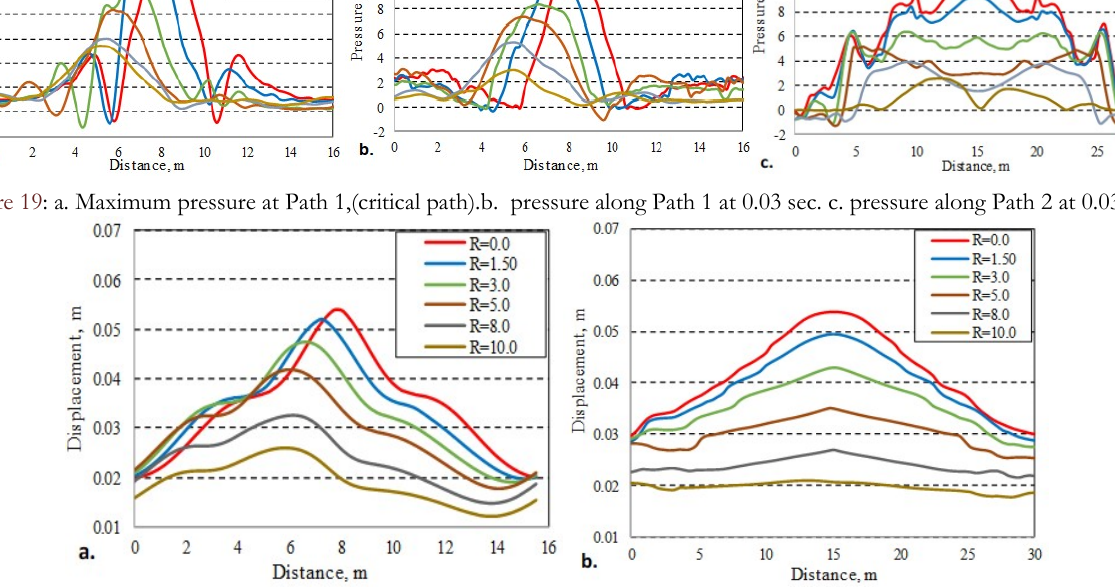
Figure 20: a. Maximum displacement with distance along Path 1 at the different horizontal distances. b. Maximum displacement with distance along Path 2 at the different horizontal distances.